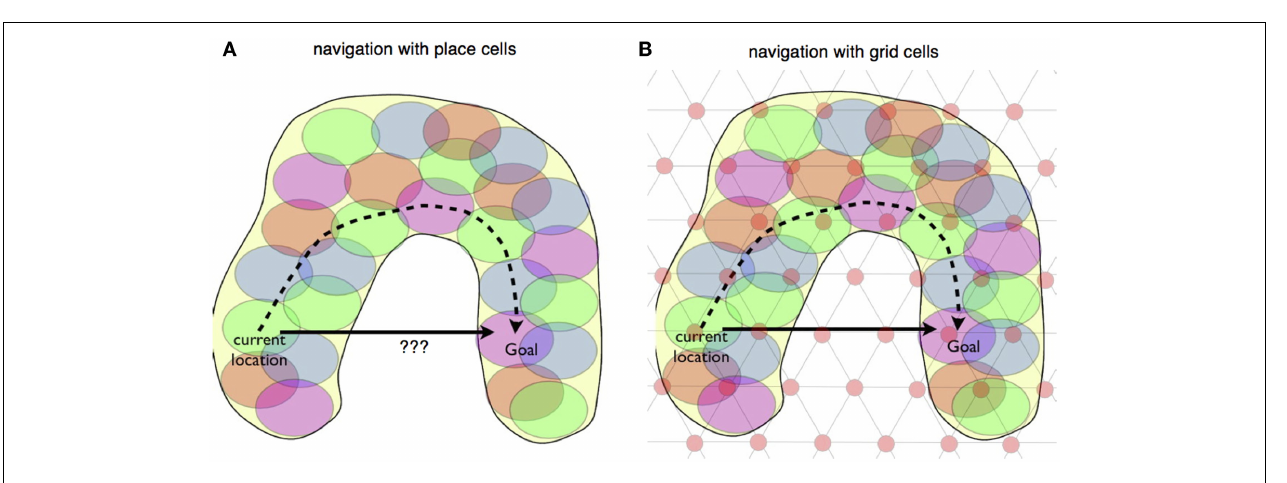
FIGURE 2 | Place cell and grid cell navigation. (A) An idealized U -shaped spatial terrain, covered with the firing fields of place cells. Many navigation models rely on the hippocampus computing a path between current location and goal that involves crossing a minimal number of firing fields,